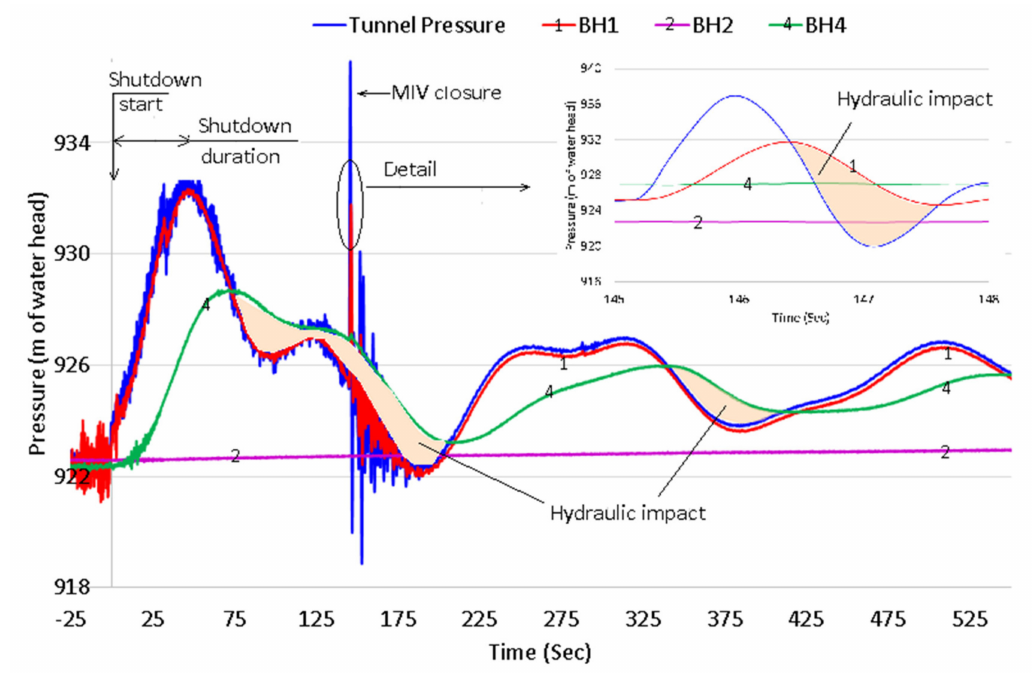
Figure 8. Typical pressure transient with pore pressure responses from boreholes BH1, BH2, and